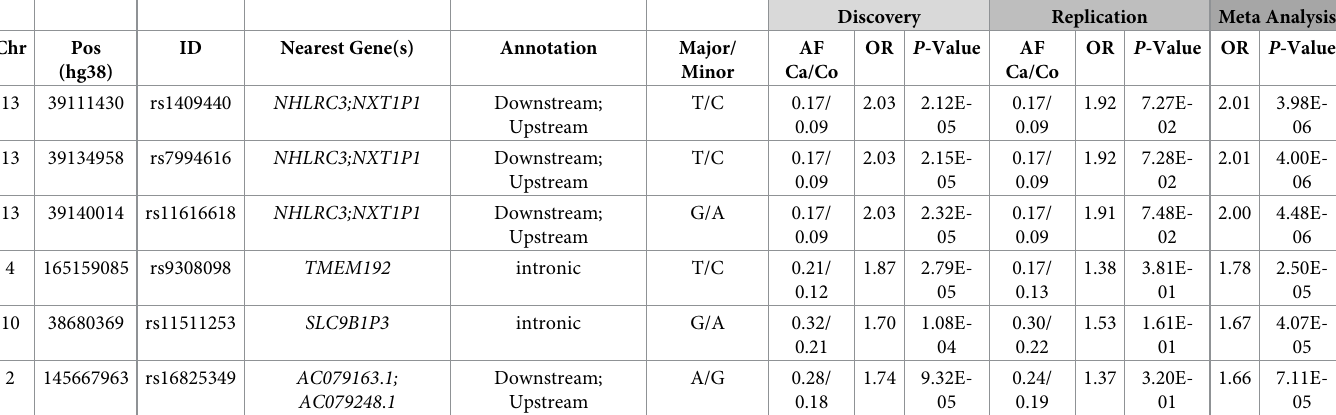
Table 4. List of the meta-analysis replicated